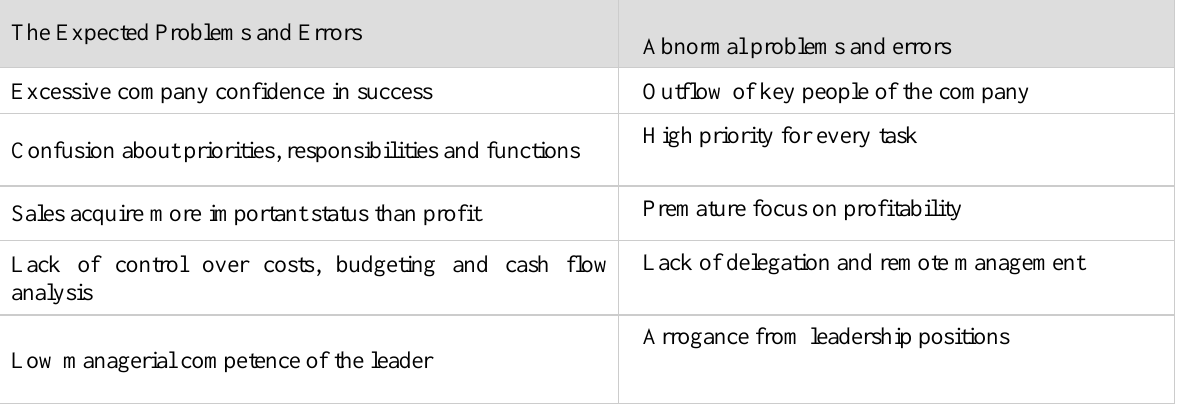
The Expected Problems and Errors